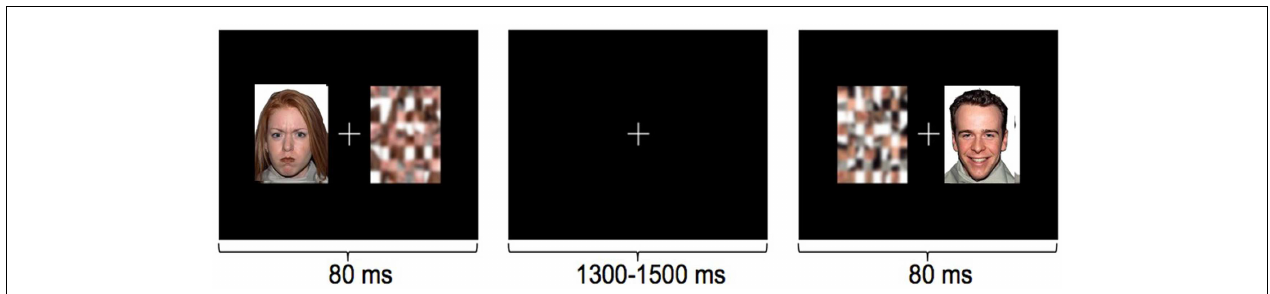
FIGURE 3 | Examples of the stimuli in the implicit emotional faces task. Angry, happy, or neutral faces were presented to the left or right of fixation, with their matched scrambled faces. Participants responded with a left or right button press, as quickly as possible, to indicate the side of the scrambled pattern.